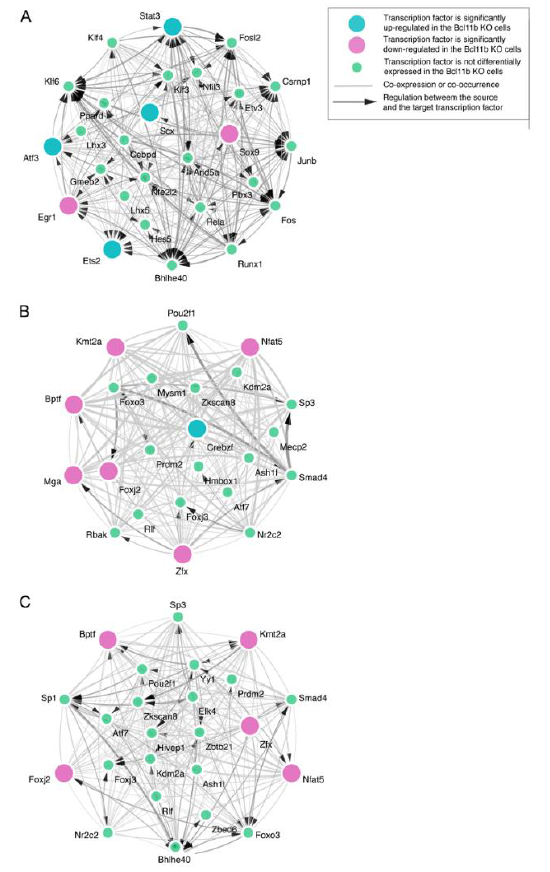
Figure 4. Gene regulatory network analysis reveals critical up-stream TFs from the gene signa- tures altered by Bcl11b deletion. Gene regulatory network analysis. ( A ) Differentially expressed TFs that are upregulated ( A ) or downregulated ( B ) in Bcl11b -deletion cells. ( C ) All differentially expressed TFs in Bcl11b -deletion